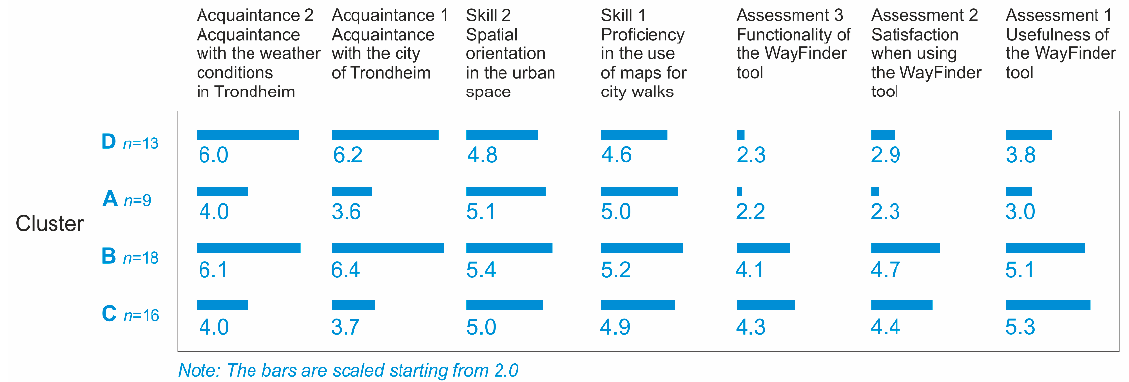
Figure 8. The division of 56 participants according to their skills and assessments of the WayFinder tool.